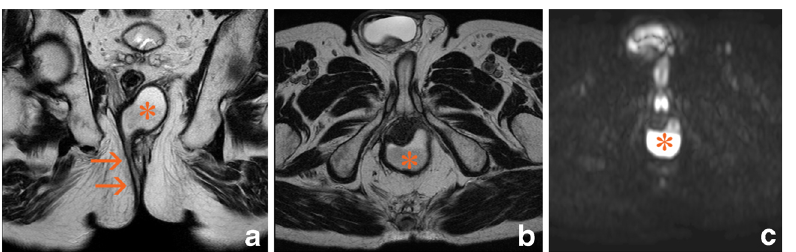
Fig. 2 Right suprasphicteric fistula (arrows) with retroanal abscess (asterisk). a Oblique-coronal T2-weighted image. b Oblique-transverse T2-weighted image. c Native oblique-transverse native diffusion-weighted image with 800 s/mm 2